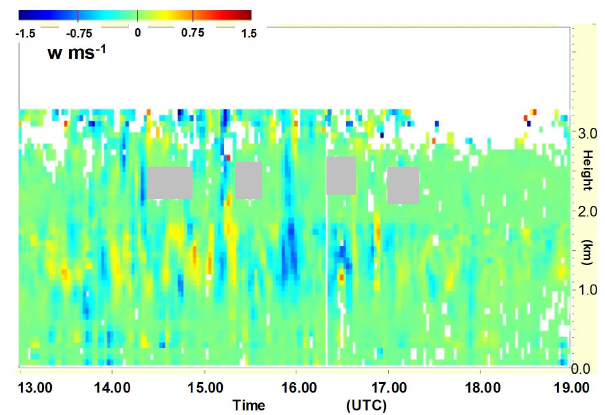
Fig. 14. Vertical speed measured by the wind profiler form the verti- cal beam at Linkenholt 29 June 2005, 13:00–19:00UTC form 75m to 3000m a.g.l., the color scale goes from − 150cm/s to